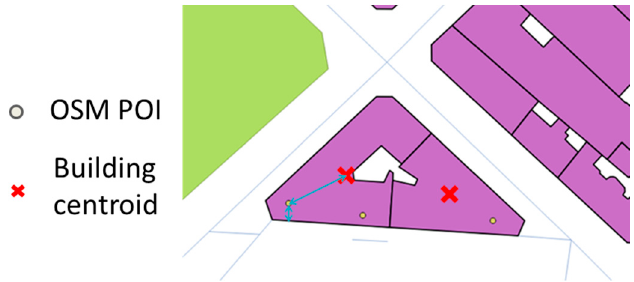
Figure 4. Three spatial relations are checked: inside a building, the distance to the building center, and the distance to the nearest boundary as a proxy for an amenity entrance (©OpenStreetMap contributors).